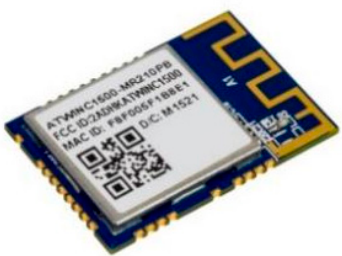
Figure 4. WINC1510 Wi-Fi module.